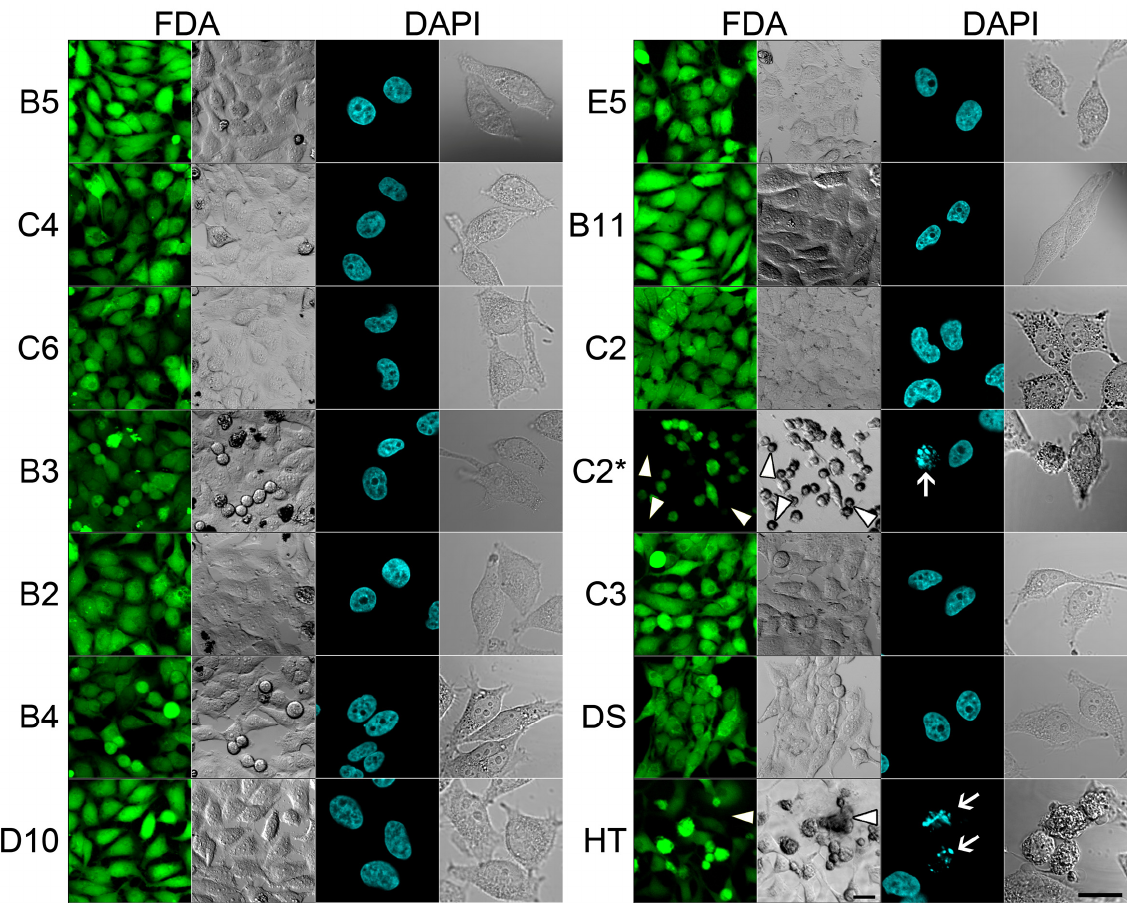
Figure 6. Viability and nuclear morphology analyses of 24 h-treated HeLa cells. FDA (green) labeling of live cells and DAPI (blue) labeling of fixed cells and their corresponding bright field images (black and white transmitted light images) are shown. Arrowheads in C2* and HT samples indicate FDA-negative dead cells and clusters. Arrows show fragmented, apoptotic-like nuclei in C2* and HT samples. C2*: Photoconverted C2; DS: Dimethyl sulfoxide; HT: 4-hydroxytamoxifen. Scale bars of 20 µm are shown in HT samples for both FDA and DAPI image